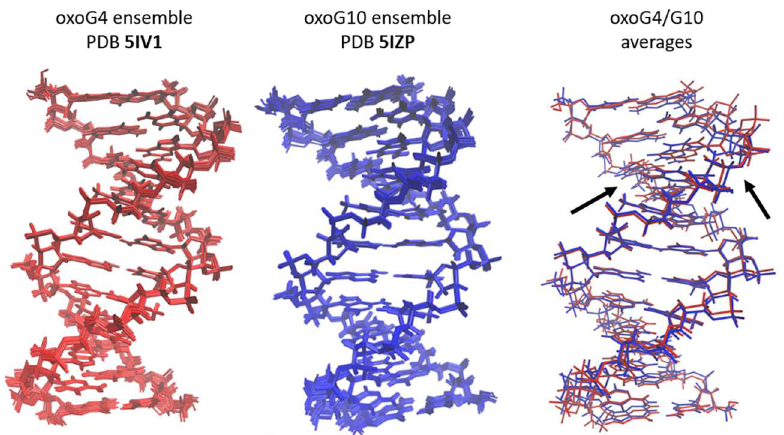
Fig 3. Ensembles and representative structures for oxoG4 and oxoG10. The entirely red ensemble (panel on the left) shows the 13 lowest energy structures and the averagedminimized structure for oxoG4, PDB ID 5IV1. The entirely blue ensemble(middle panel) shows the 14 lowest energy structures and the averaged minimized structure for oxoG10, PDB ID 5IZP. The panel on the right shows an overlay of the averaged minimized structures for both oxoG4 and oxoG10, in red and blue, respectively. In this last panel, the arrows show the generallocation of the two modified base pairs, C 3 :oxoG 4 and C 9 :oxoG 10